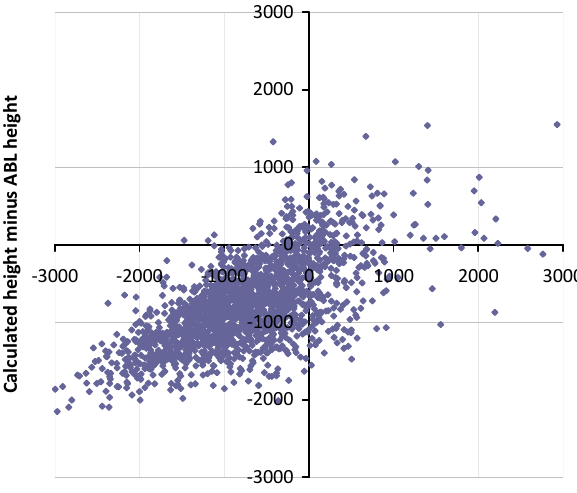
Fig. 5. Comparison of difference between the H abl and the pre- dicted (Eqs. 10, 13) and observed fire plume